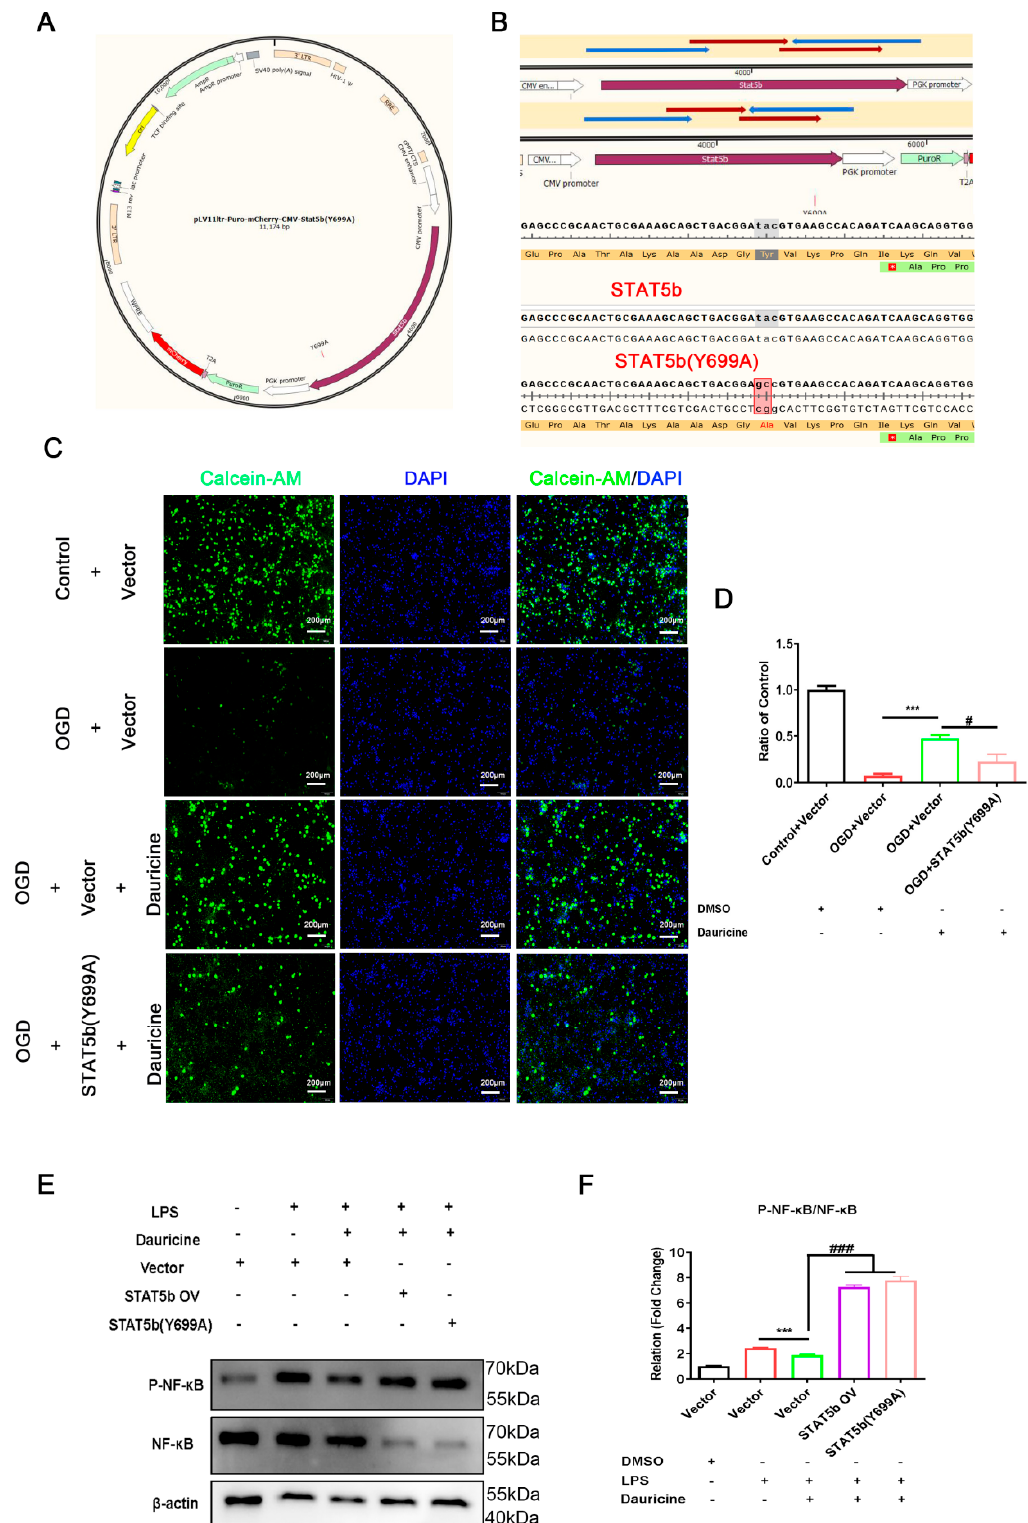
Figure 7. STAT5b (Tyr699 mutant) reversed the neuroprotection of neuron and activated the NF- κ B pathway of microglia. ( A ) Vector map of STAT5b (Tyr-699 mutation). ( B ) Sequencing and matching results of STAT5b OV and STAT5b (Y699A). ( C ) The primary neurons were transfected with STAT5b OV and STAT5b (Y699A) plasmids for 48 h, and the neurons were deprived of oxygen and sugar for 30 min, then reperfusion for 3 h, and neurons were stained with calcein-AM and DAPI, and quantified (D). n = 5, (OGD + Vector) group vs. (OGD + Vector +dauricine) group, *** p < 0.001;